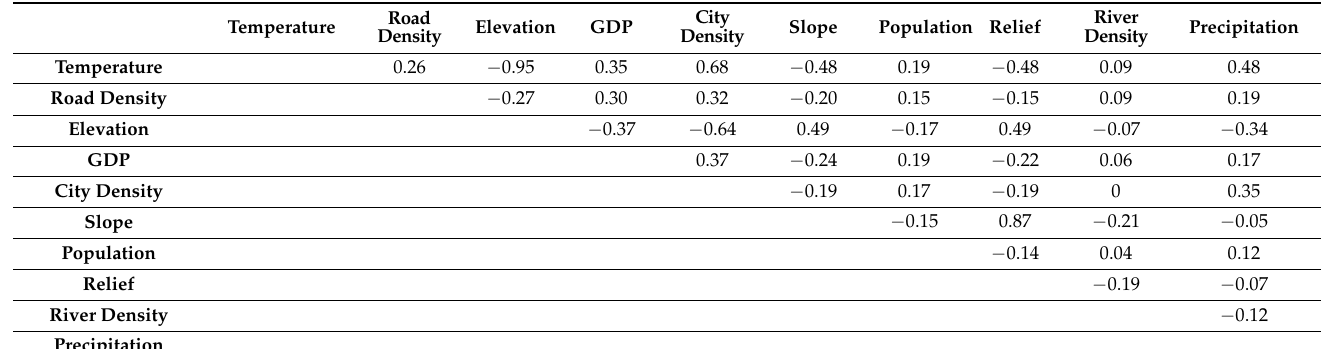
Table 2. Pearson correlation coefficient between different